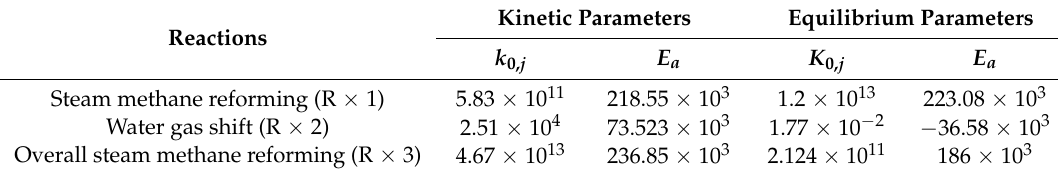
Table A2. Kinetic and equilibrium parameters for reforming